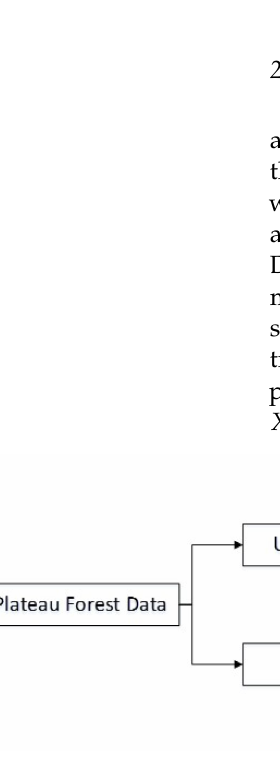
Figure 6. The structure of the proposed plateau forest monitoring